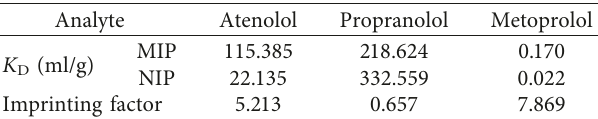
Table 2: Selectivity of MMA propanol polymer by bulk poly- merization ( n � 3).